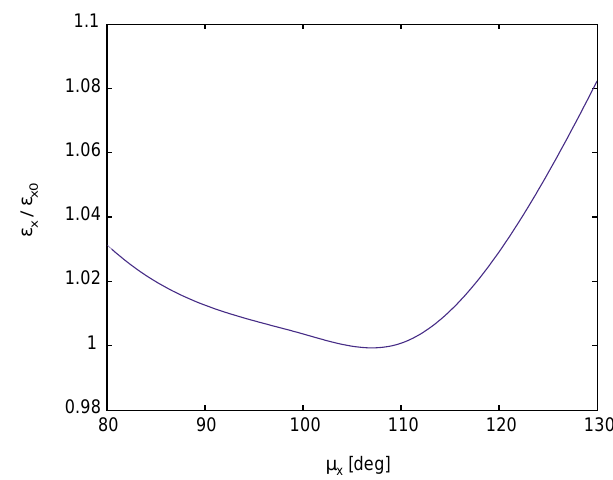
FIG. 4. (Color) Relative horizontal emittance as a function of horizontal phase advance per wiggler FODO cell calculated with MAD [13]. The vertical phase advance per FODO cell is held constant at m y (cid:1) 72 ± and g´ x 0 (cid:1) 3 m